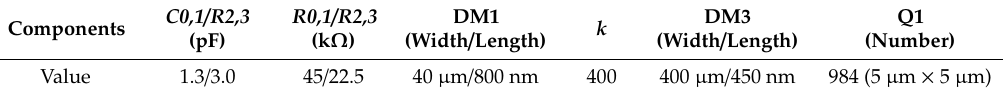
Figure 4. Implementation of the linear regulator core circuit. Table 2. Main component sizes of the linear regulator core circuit.